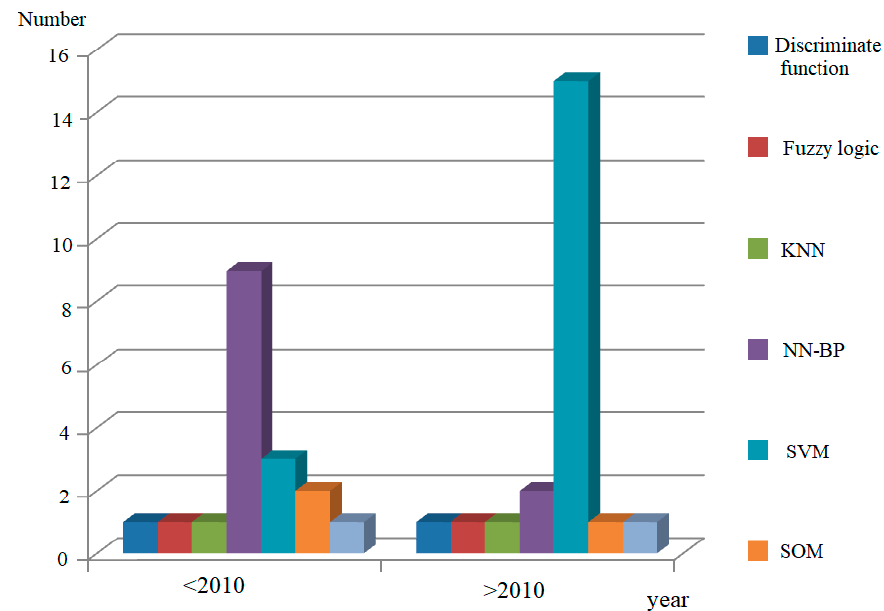
Figure 11. Distribution of classification methods.